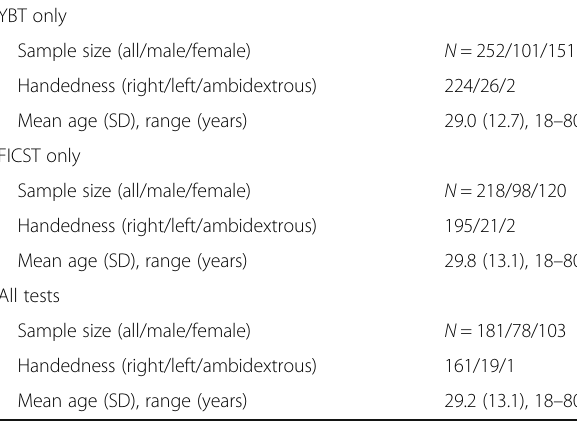
FICST Facial Identity Card Sorting Test, SD standard deviation, YBT Yearbook